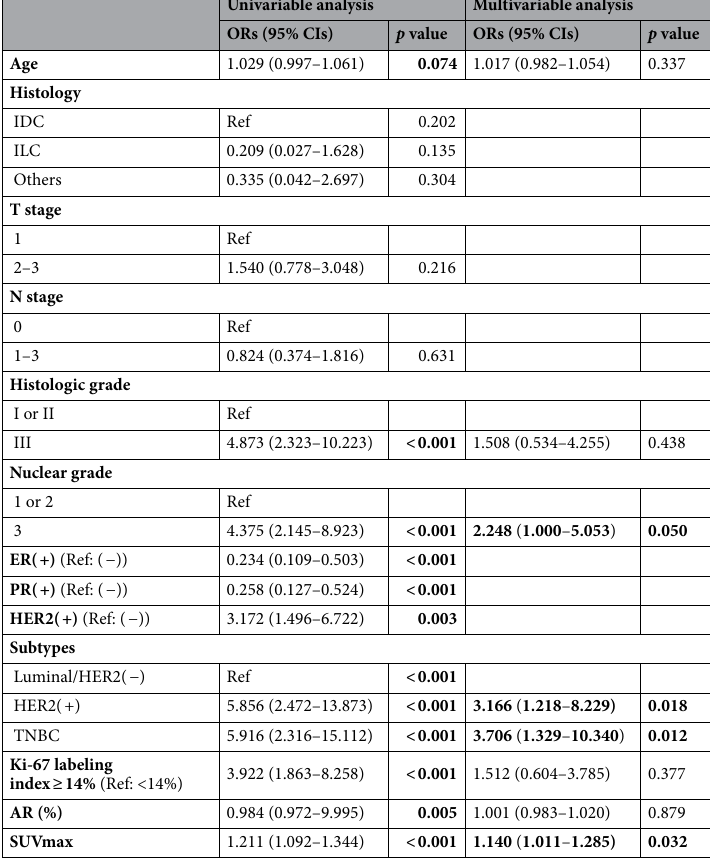
Table 3. Predictive factors for tumors with high tumor-infiltrating lymphocyte levels. Bold font is used to also highlight statistically significant values. ANC absolute neutrophil count, ALC absolute lymphocyte count, ER estrogen receptor, HER-2 human epidermal growth factor receptor-2, IDC invasive ductal carcinoma, PR progesterone receptor, TNBC triple-negative breast cancer, OR odds ratio, CI confidence interval, AR androgen receptor, ILC invasive lobular